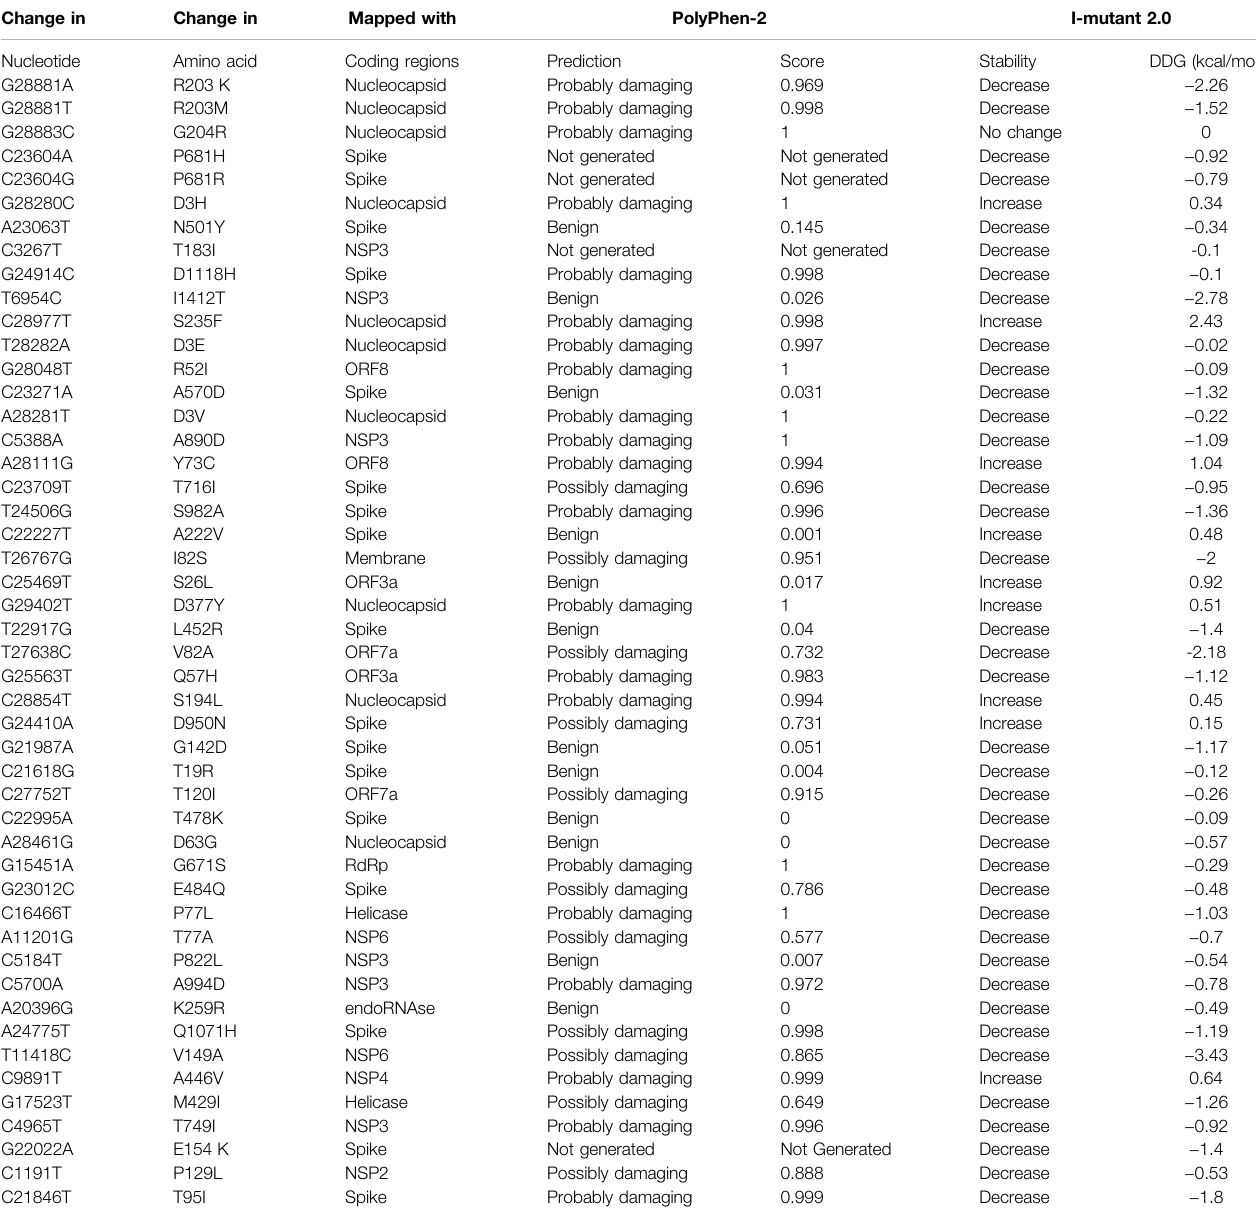
TABLE 5| Sequence and structuralhomology-based prediction ofnon-synonymous substitutionas hotspot mutations along with their protein structural stabilityfor 71,038 global SARS-CoV-2 genomes. Change